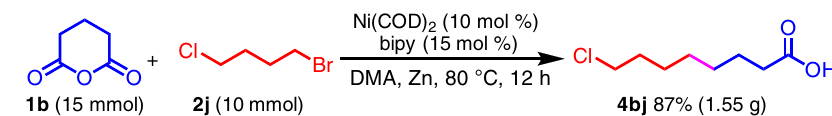
Fig. 3 Scale up the transformation to 10.0 mmol. 1-Bromo-4-chlorobutane reacted with 1b to give the desired product 4bj with 87% yield.